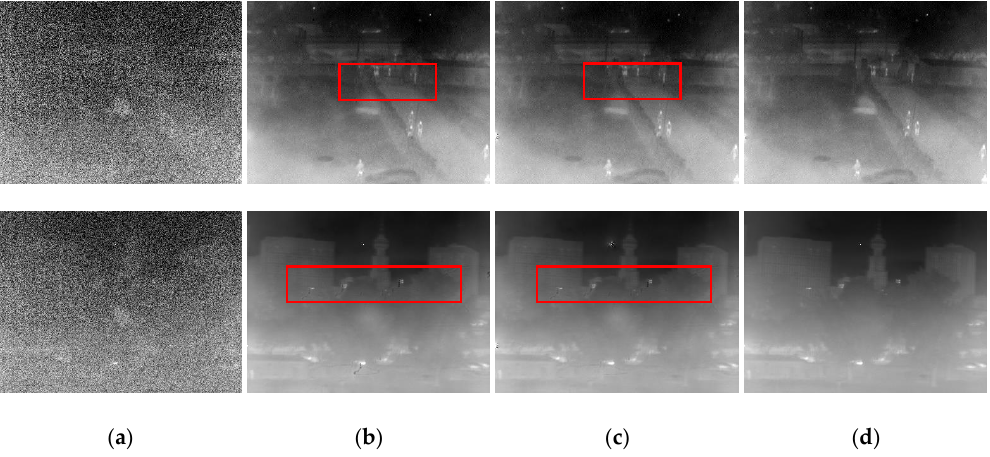
Figure 11. NUC performance comparison when the imager moved randomly without any intentional jitter and occlusion: ( a ) uncorrected image; ( b) Gated–LMS; ( c ) ST–LMS; ( d ) our image. The top row is the 794th frame. The bottom row is the 3289th frame.